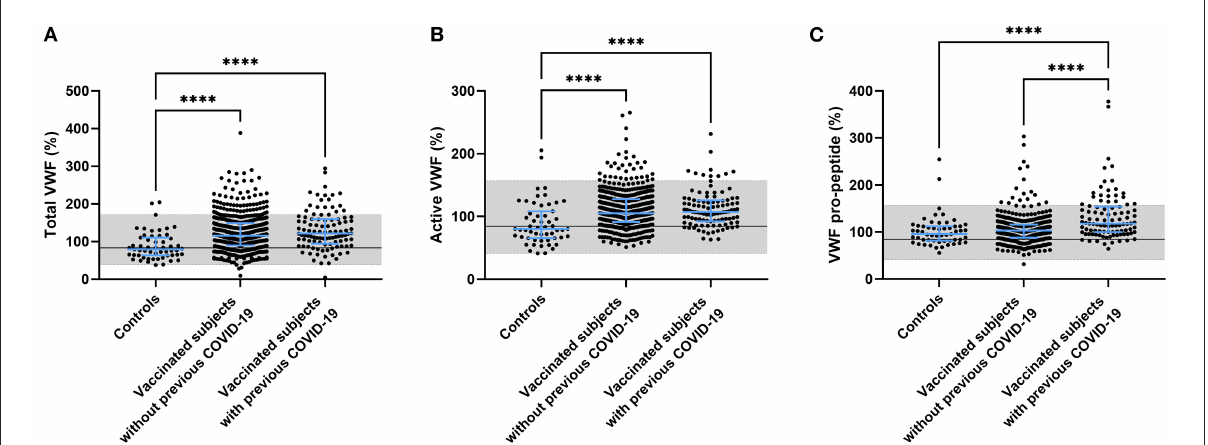
FIGURE4 Endothelial activation in controls and subjects vaccinated with ChAdOx1-S with and without prior COVID-19 infection. Endothelial activation was assessed by the measurement of total VWF (A) , active VWF (B) and VWF pro-peptide (C) . Reference values for each test are indicated as the gray area in the dot plot. Differences between the groups were analyzed by ANOVA or Kruskal-Wallis analysis, depending on the distribution of the data. P -values below 0.05, 0.01, 0.001, and 0.0001 were marked respectively.